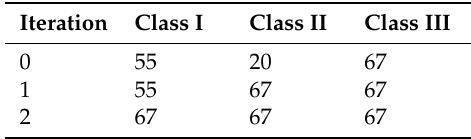
Table 6. Haiti—Random Over-sampling of data [39]. .